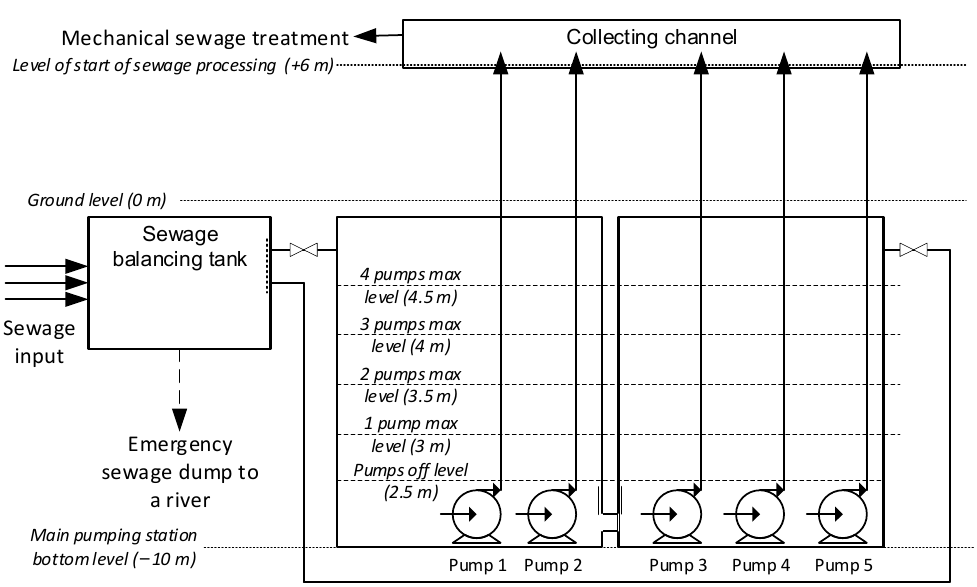
Figure 1. Technological diagram of the main pump station of the WWTP.